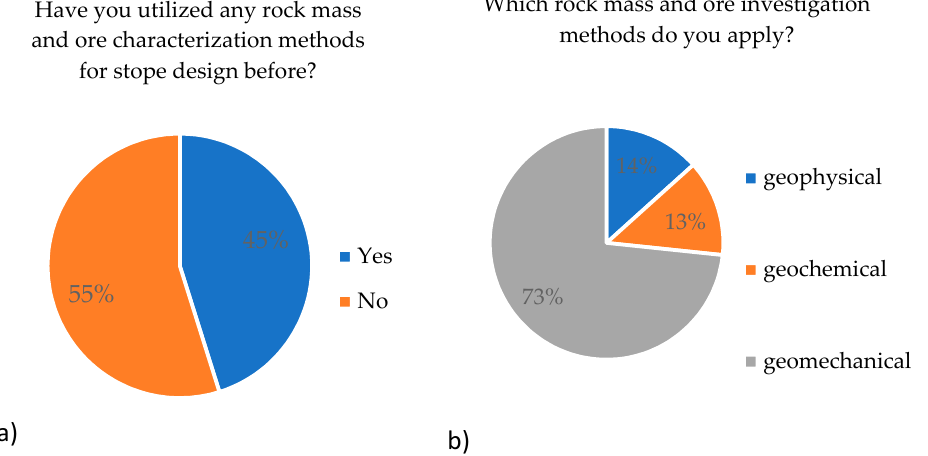
Figure 12. The current utilization of rock mass and ore investigation methods in the mines ( a ) and the type of method that is used to collect rock mass and ore data ( b ).